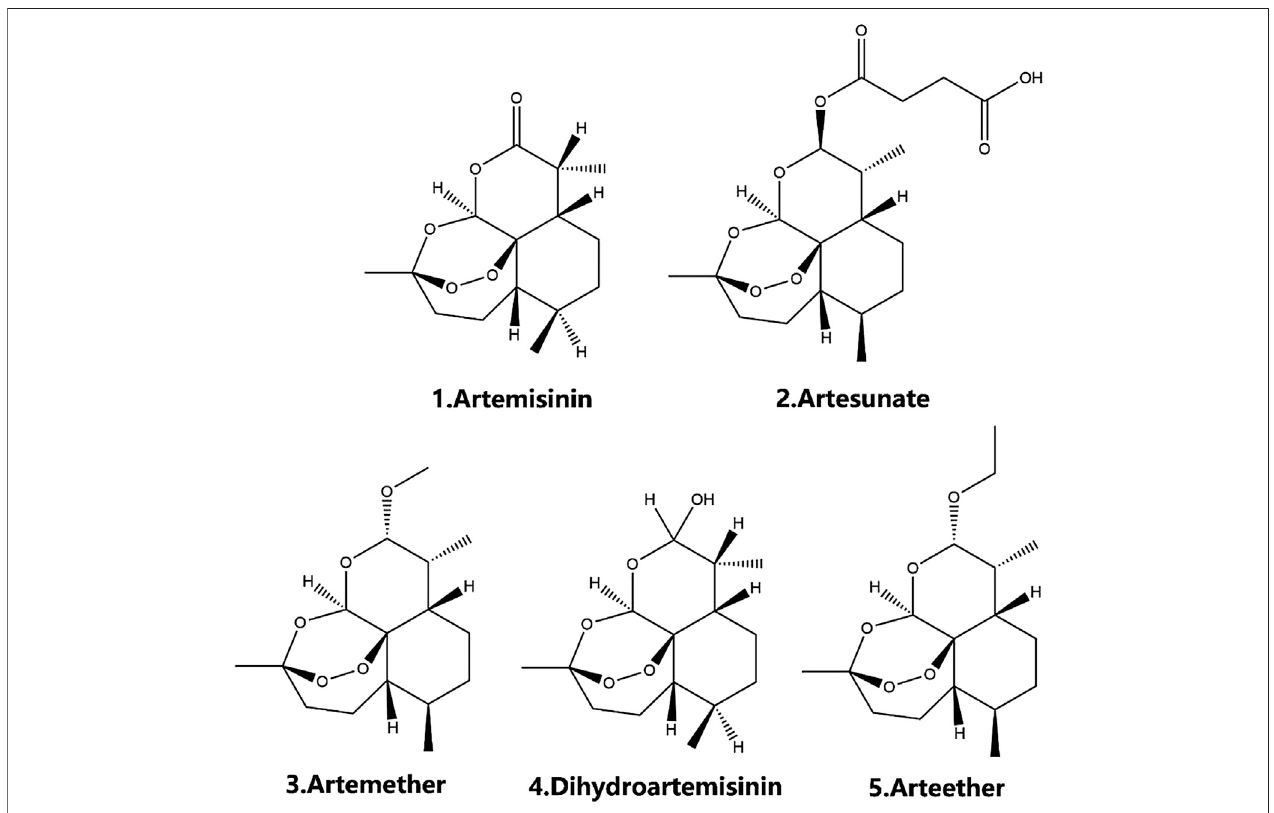
FIGURE 1 | The chemical structure of artemisinin